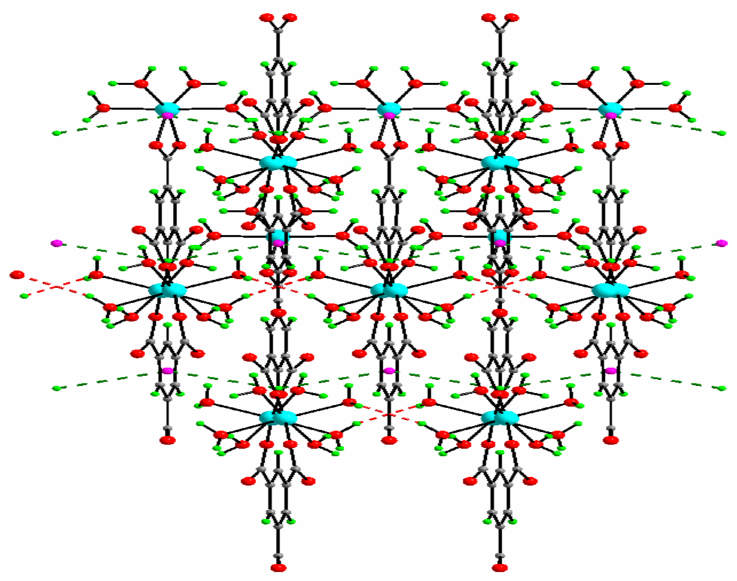
Figure 27. 3D framework in [M 3 ( btc ) 2 (H 2 O) 12 ] [M = Ni and Co]. Reprinted with permission from Ref. [58]. Copyright 2019 Elsevier.